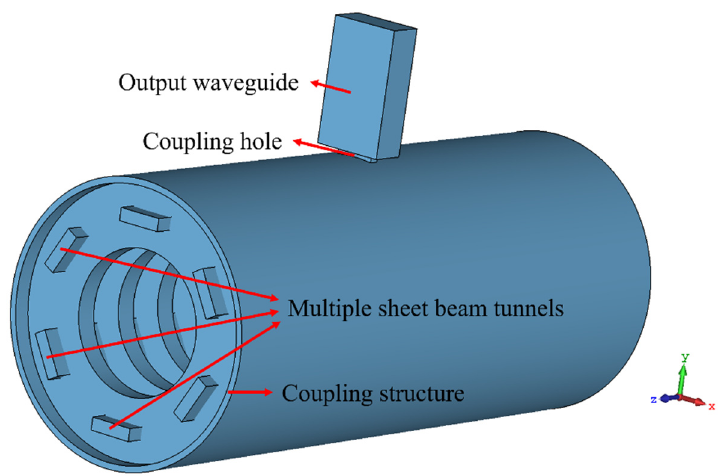
Figure 2. A schematic of the multiple sheet beam EIO with eleven gaps.